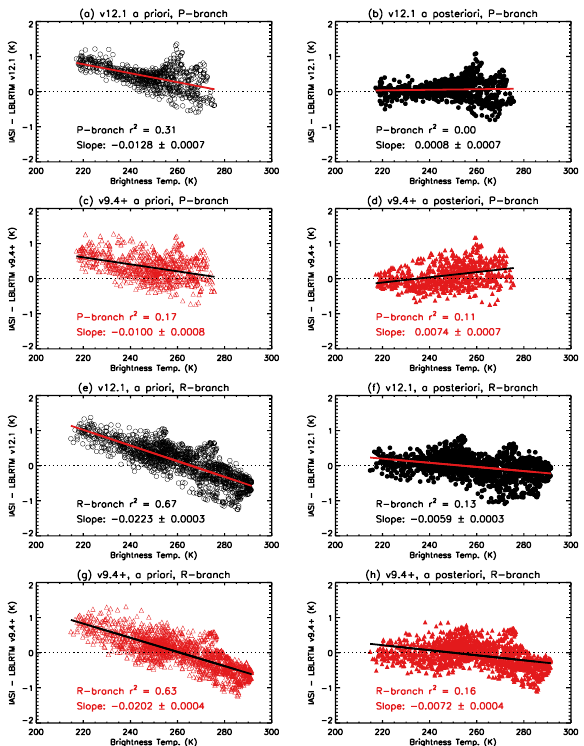
Fig. 17. A priori (left column, open symbols) and a posteriori (right column, closed symbols) mean residuals of 120 scans in the P- and R-branches of the H 2 O ν 2 band versus observed brightness temper- ature for an example spectrum with 1.5cm PWV. Black circles are for residuals from v12.1, while red triangles are for residuals from v9.4 + .